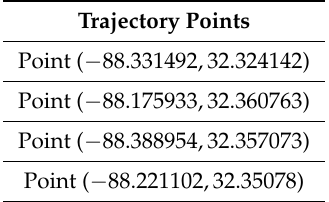
Table 5. Trajectory Representation in a